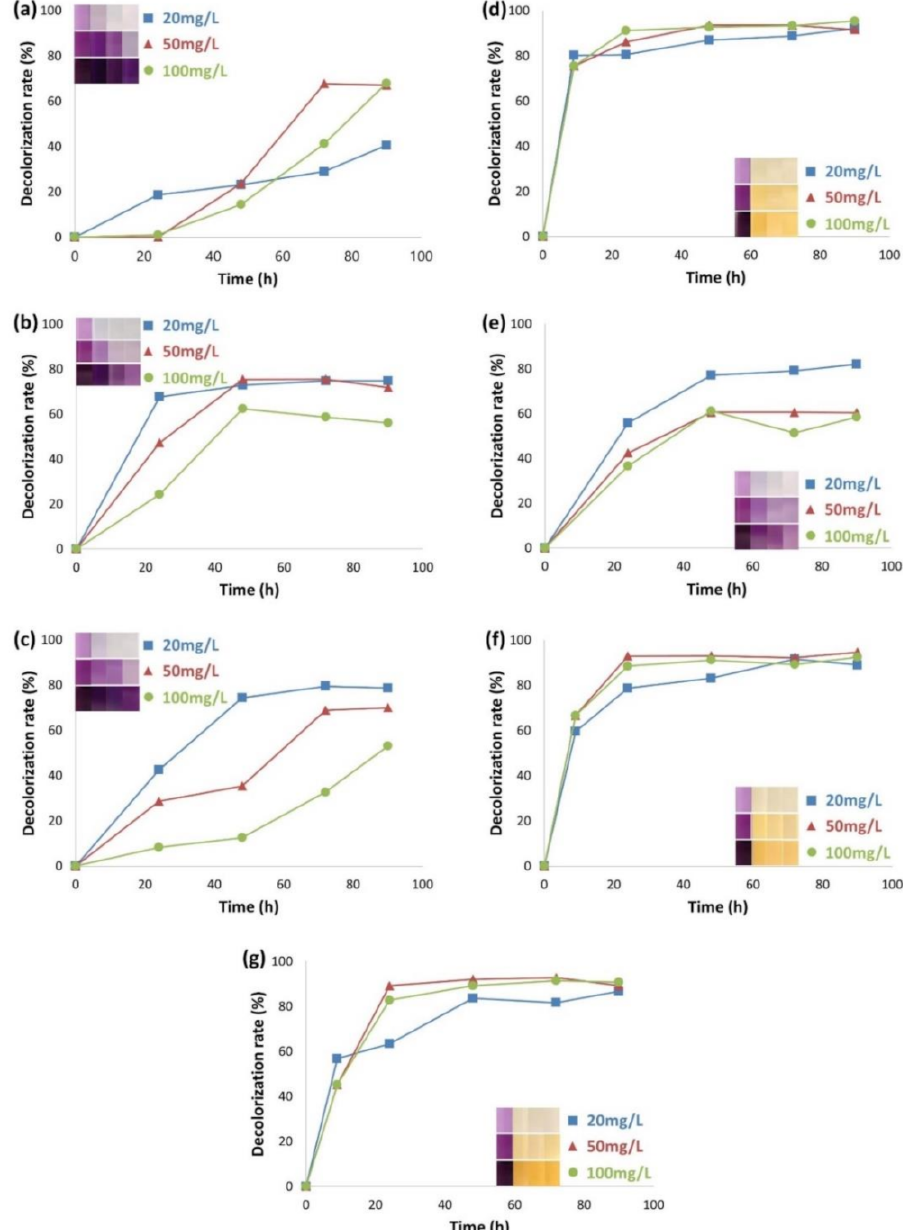
Figure 1. Time course for the azo dye decolorization rates of various pure cultures and consortia of bacteria and yeasts. ( a ) B-1, ( b ) B-2, ( c ) B-C, ( d ) Y-1, ( e ) Y-2, ( f ) Y-C, and ( g ) T-C. The four color boxes show the sample’s color difference over four days. The legend (mg/L) represents different concentrations of the AB113